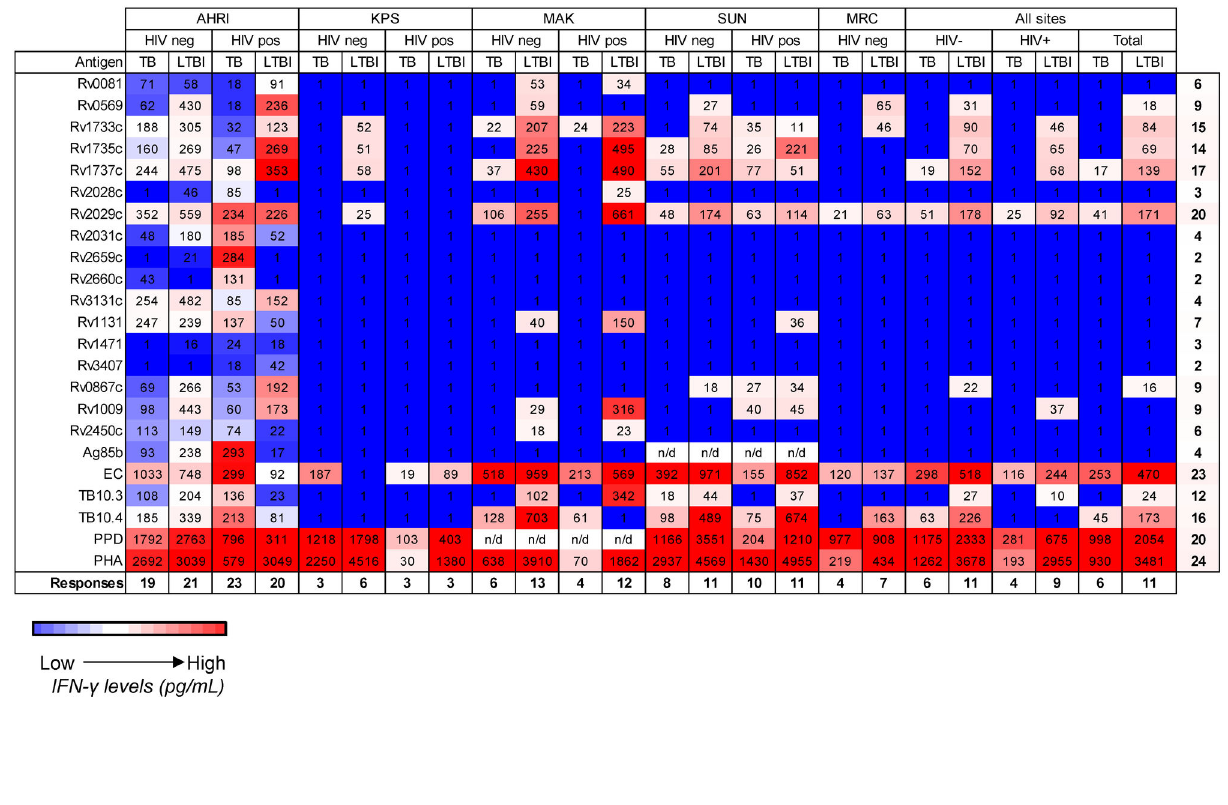
Figure 1. Heat map of IFN-γ responses to secreted, latent, and reactivation Mtb antigens stratified according to HIV status, TB status and location. . Median levels of IFN-γ are shown (pg/mL). Red indicates relatively high levels of IFN-γ and blue indicates relatively low levels. HIV + = human immunodeficiency virus positive; HIV - = human immunodeficiency virus negative; TB = active tuberculosis; LTBI = latently TB infected; n/d = not done; SUN = Stellenbosch University, South Africa; MRC = Medical Research Council, The Gambia; AHRI = Armauer Hansen Research Institute, Ethiopia; KPS = Karonga Prevention Study, Malawi; MAK = Makerere University, Uganda. The right column indicates the number of groups (out of a possible 24) who responded to a particular antigen. PPD was not used at MAK nor was Ag85b used at SUN, so the maximum number for these is 20. doi: